Question: Summarize what this figure shows in one sentence.
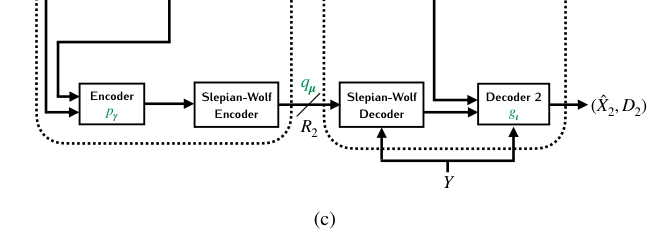
Answer: The three lossy compression systems that we consider: (a) learned compressor sending a joint description for both decoders using a classic entropy coder (i.e., the joint formulation, see Eq. (13)), (b) learned compressors sending individual descriptions to both decoders using classic entropy coders (i.e., the marginal formulation, see Eq. (14)), and (c) using a combination of a classic entropy coder and an ideal Slepian–Wolf coder (i.e., the conditional formulation, see Eq. (15)). The learned parameters are indicated in green.